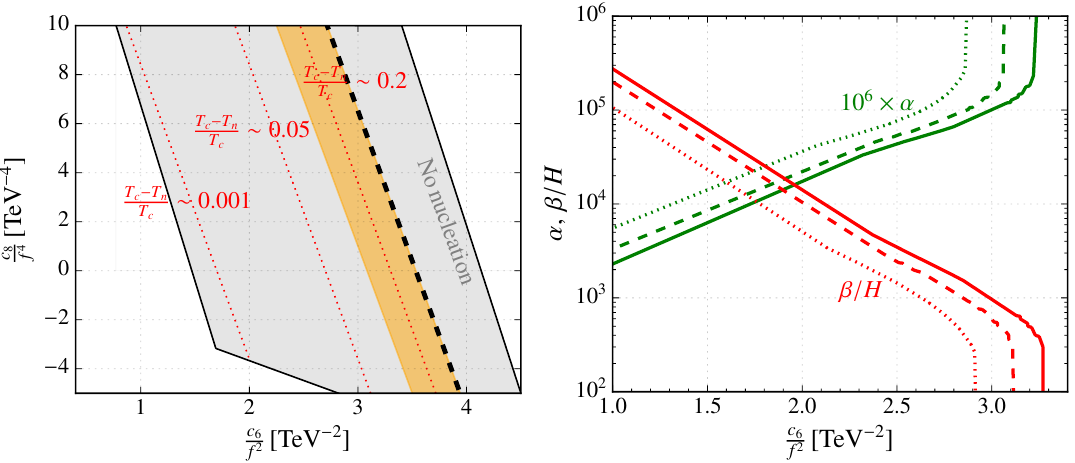
Figure 4 . Left panel) The values of ( T c (cid:0) T n ) =T c in the plane c 6 =f 2 { c 8 =f 4 (dotted lines). The rest stands as in (cid:12)gure 3. Right panel) The values of (cid:12)=H and 10 6 (cid:2) (cid:11) as a function of c 6 =f 2 for c 8 =f 4 = 5 TeV (cid:0) 4 (dotted curves), c 8 =f 4 = 2 TeV (cid:0) 4 (dashed curves) and c 8 =f 4 = 0 (solid